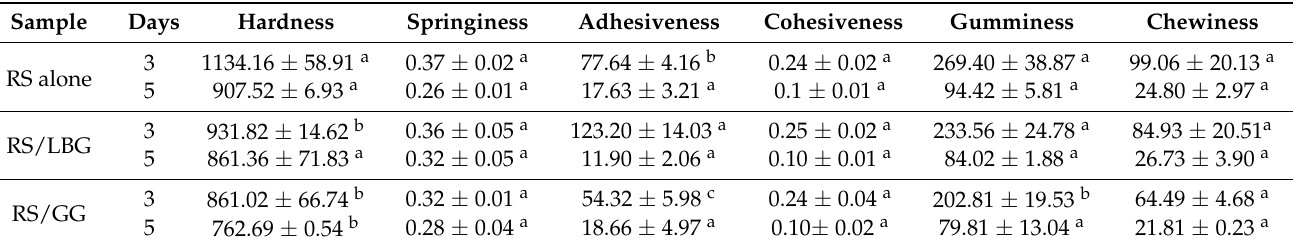
Table 6. TPA texture parameters of RS alone, RS containing locust bean gum (RS/LBG), and RS containing guar gum (RS/GG) during cold storage